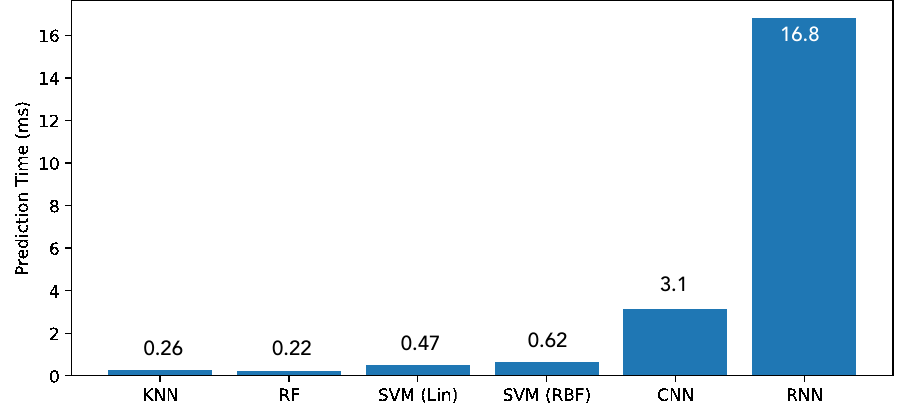
Figure 13. Mean prediction time in ms for each of the best